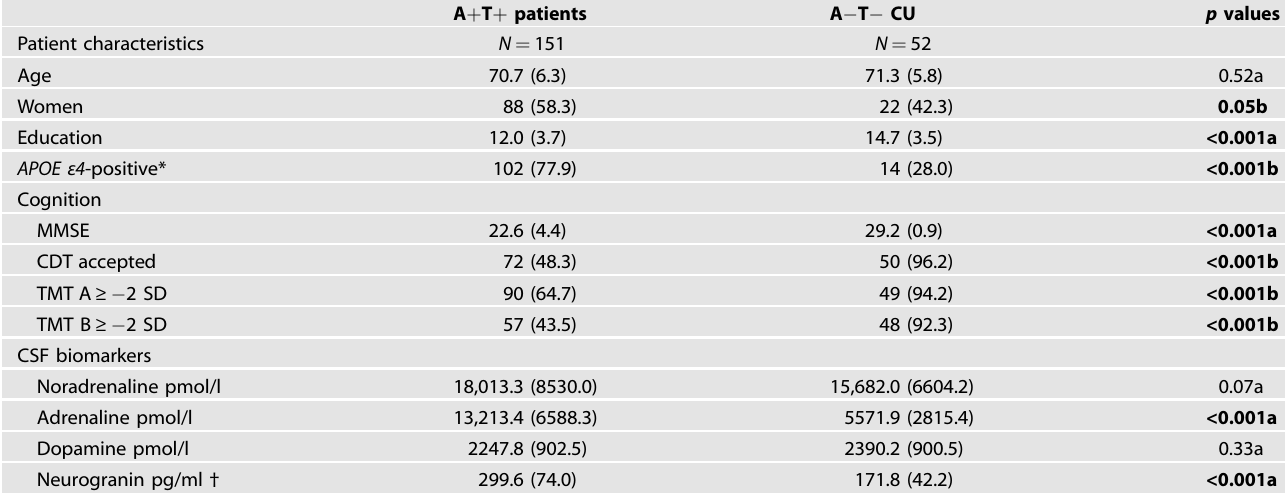
Bold values identify statistical signi fi cance. Data are presented as N (%) and mean (SD). a = T -test, b = Chi square. CU cognitively unimpaired, MMSE mini mental state examination, CDT clock drawing test, TMT trail making test. % Valid percent without missing. *Missing genotype in 22. † Missing in 53 A + T +